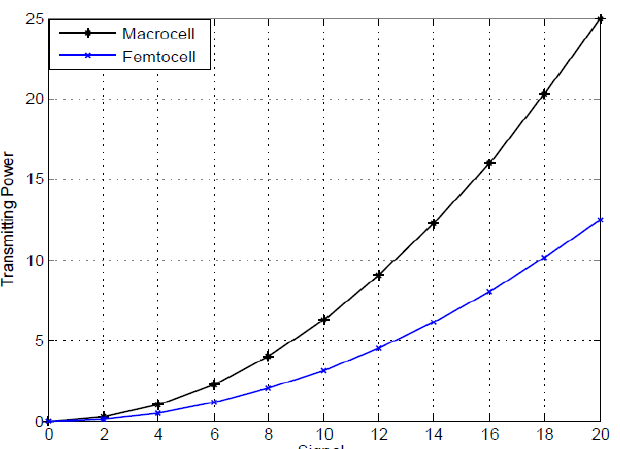
Fig 7: Iteration of transmitting power over signal